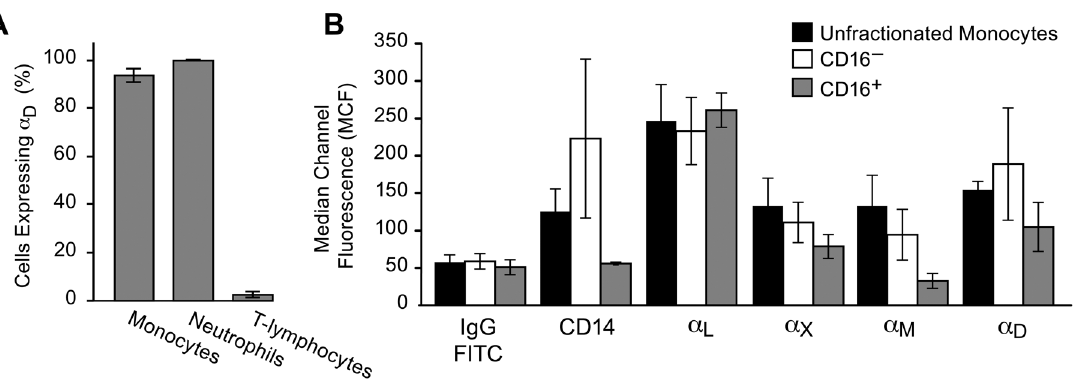
Figure 1. Integrin a D b 2 is highly expressed on myeloid leukocytes in human blood. A. Whole venous blood from healthy volunteers was fixed and expression of a D b 2 on leukocyte subtypes was examined using mAb 169A (anti- a D ) and FITC-conjugated mAbs against CD14, CD15, and CD3 as described in Materials and Methods. The percent of each cell type positive for a D b 2 is indicated by the bars. The error bars indicate the mean and SD of determinations using samples from four subjects. B. Monocytes were separated from venous blood of healthy volunteers and further separated into CD16 + and CD16 2 CD14 + subpopulations as described in Materials and Methods. Surface expression of a D b 2 , a L b 2 , a M b 2 , and a X b 2 was examined by flow cytometry using FITC- or ALEXA-488-conjugated antibodies and isotype-matched IgG controls. Cells in each monocyte fraction were also stained for CD14. These data indicate means and standard deviations in results from 3 experiments using samples from different subjects.